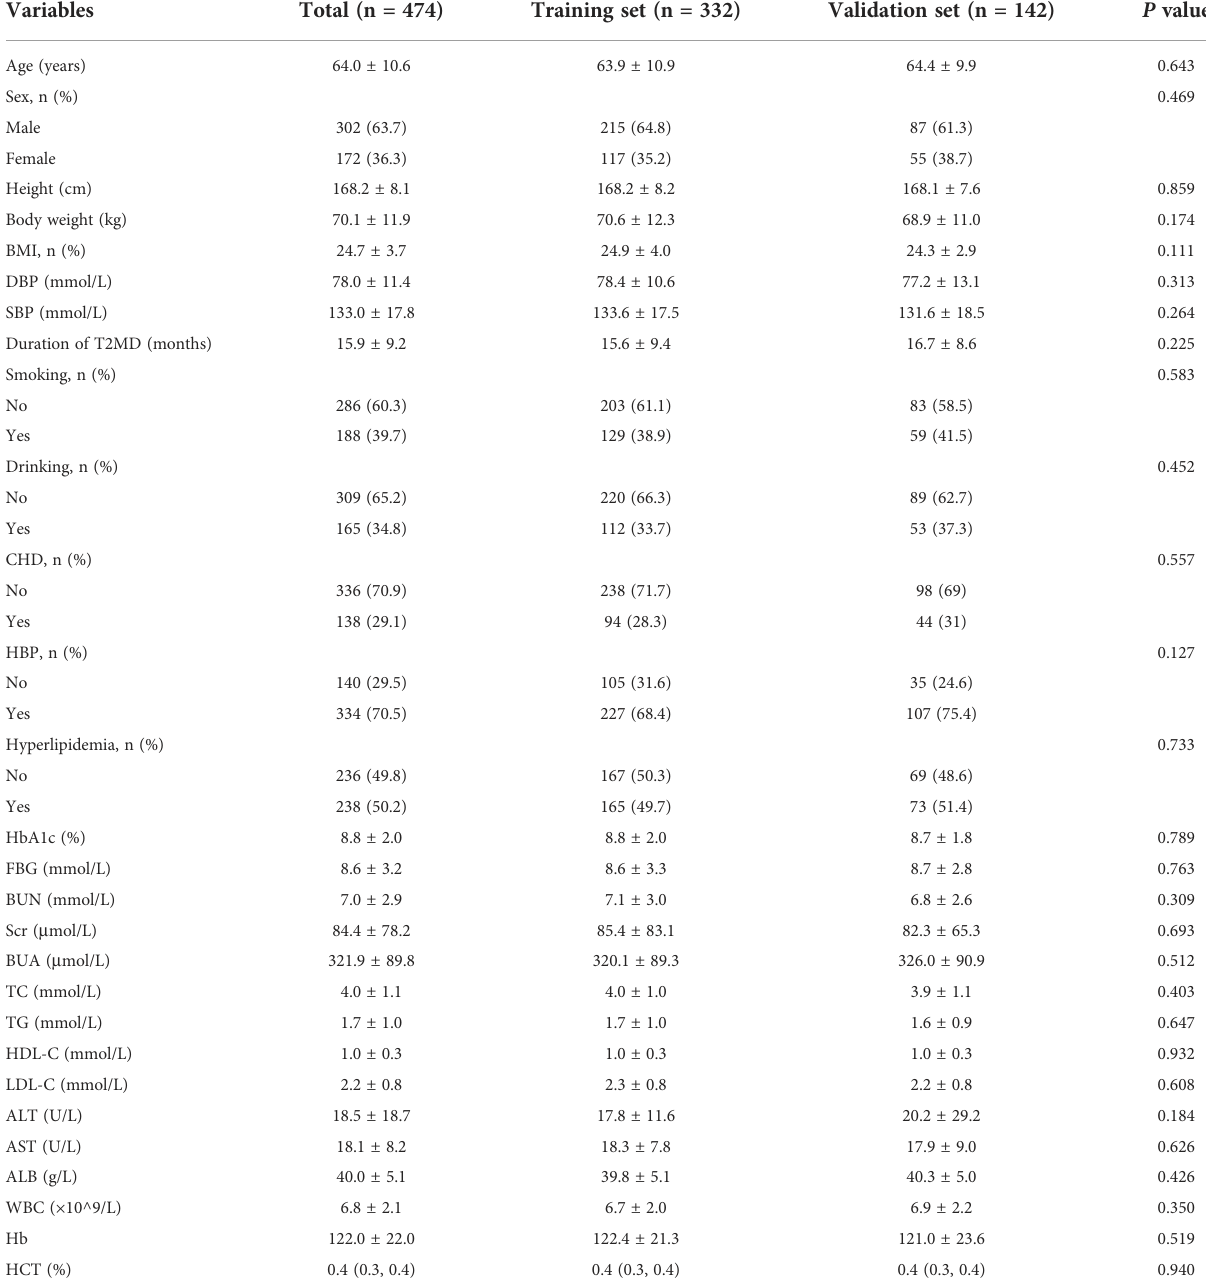
TABLE 1 Baseline characteristics of patients in the training set and validation